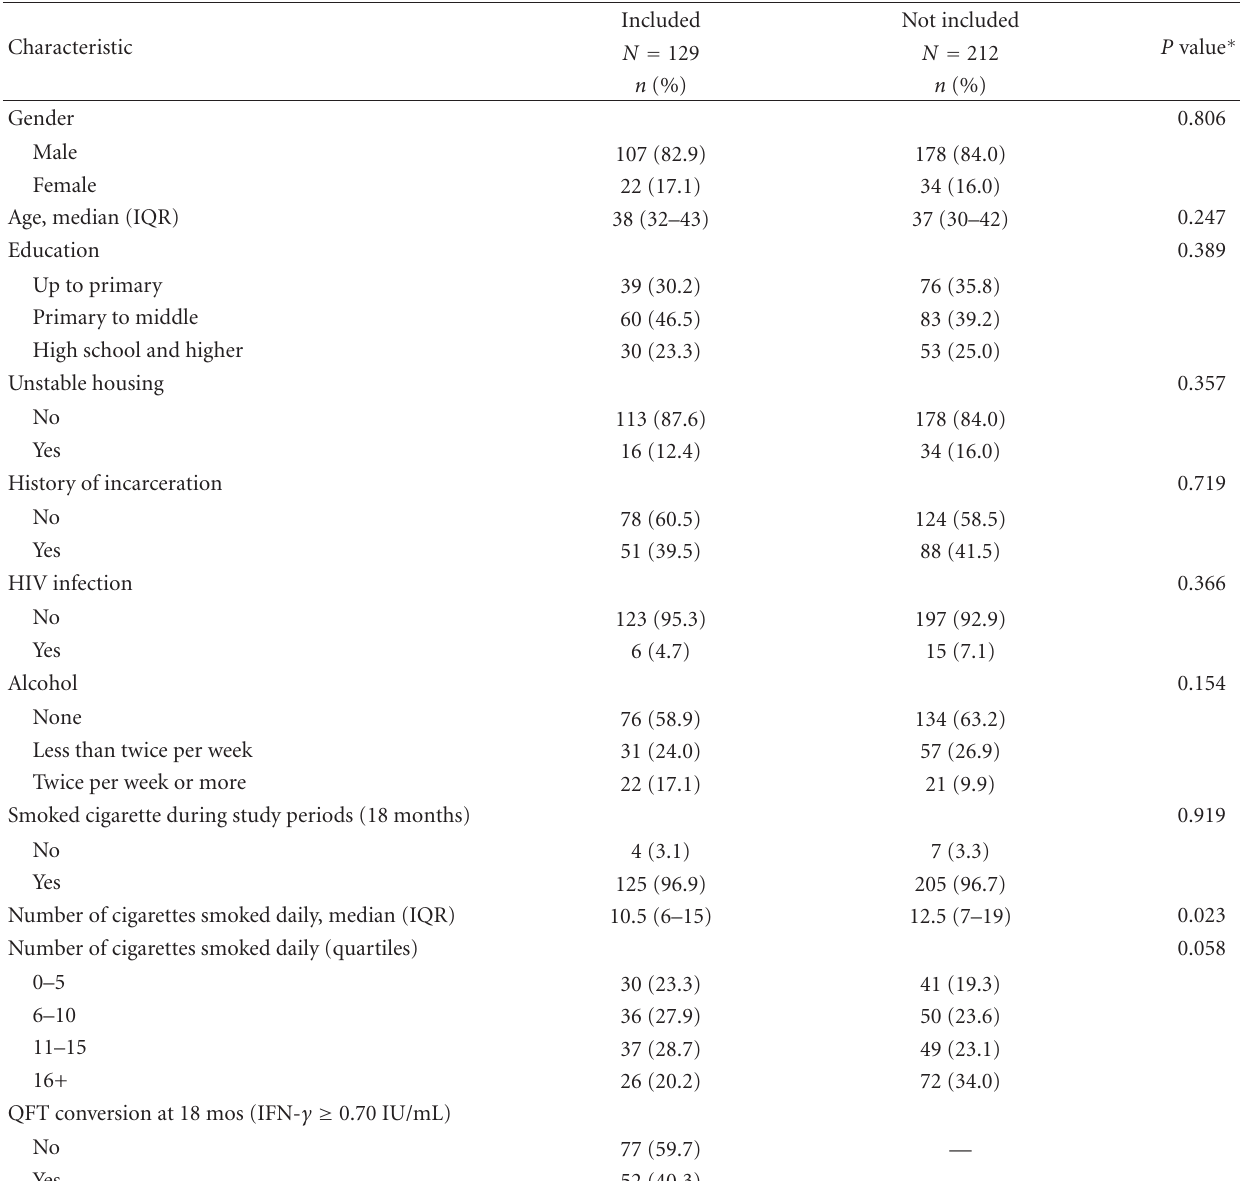
Table 1: Demographic and behavioral characteristics of participants with negative QFT results (IFN- γ < 0.35 IU/mL) at baseline, included versus not included in the analysis; Tijuana, Mexico,